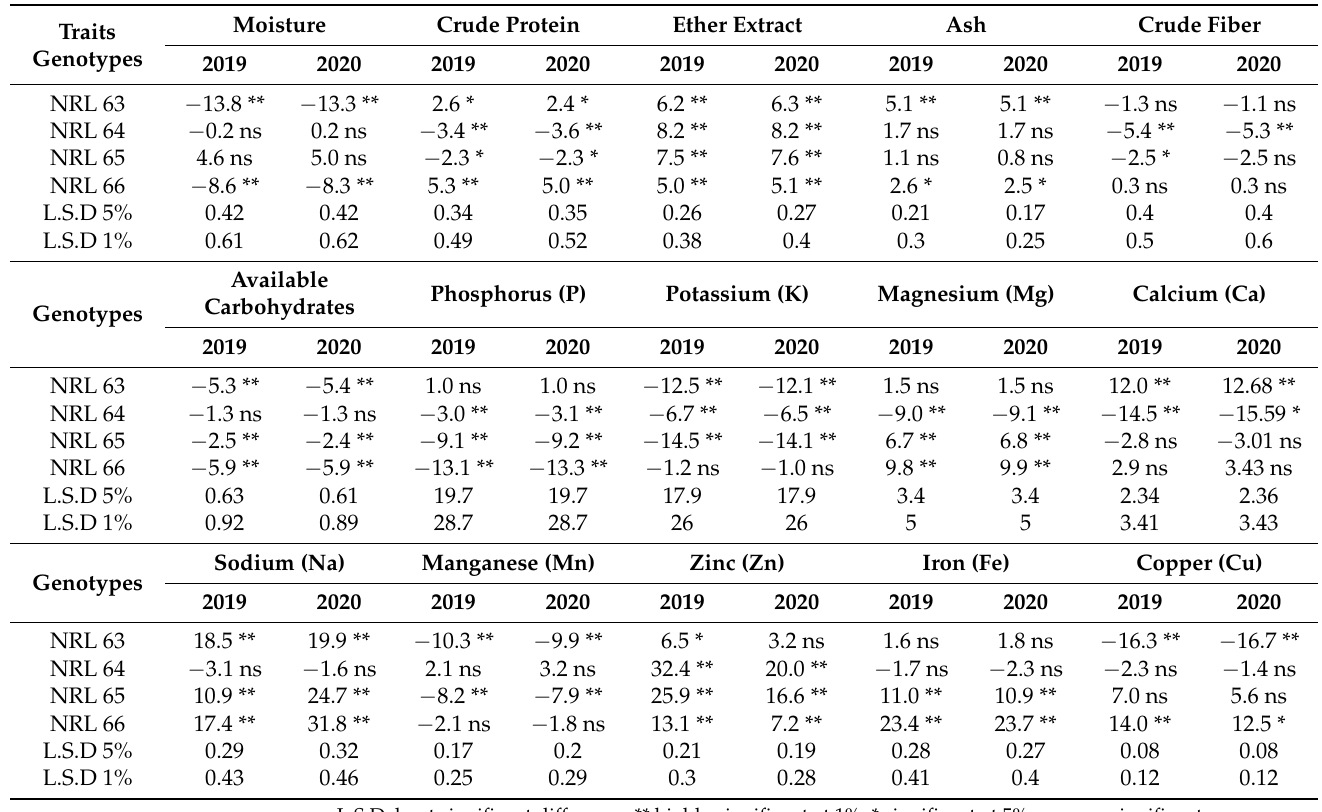
Table 14. Estimates of the percentage of advantage over commercial variety for gross chemical composition (%) and minerals content (mg/100 g) of stabilized rice bran samples of the studied genotypes during the 2019 and 2020 growing